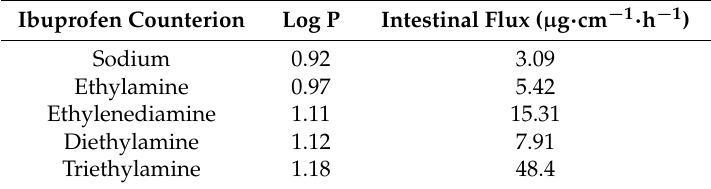
Table 2. Counterions of ibuprofen and their respective log P values and membrane absorption